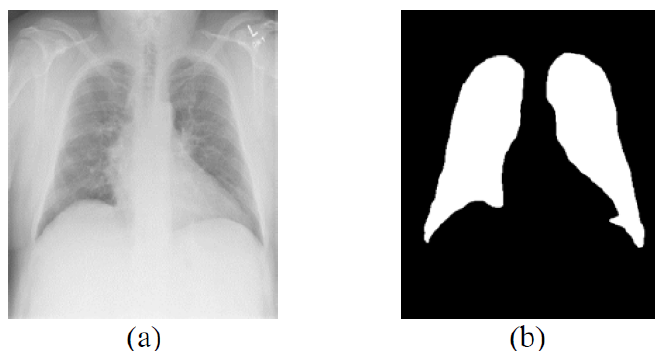
Figure 3. Ground truth example of the LIDC-IDRI dataset. ( a ) Original image. ( b ) Ground truth image.